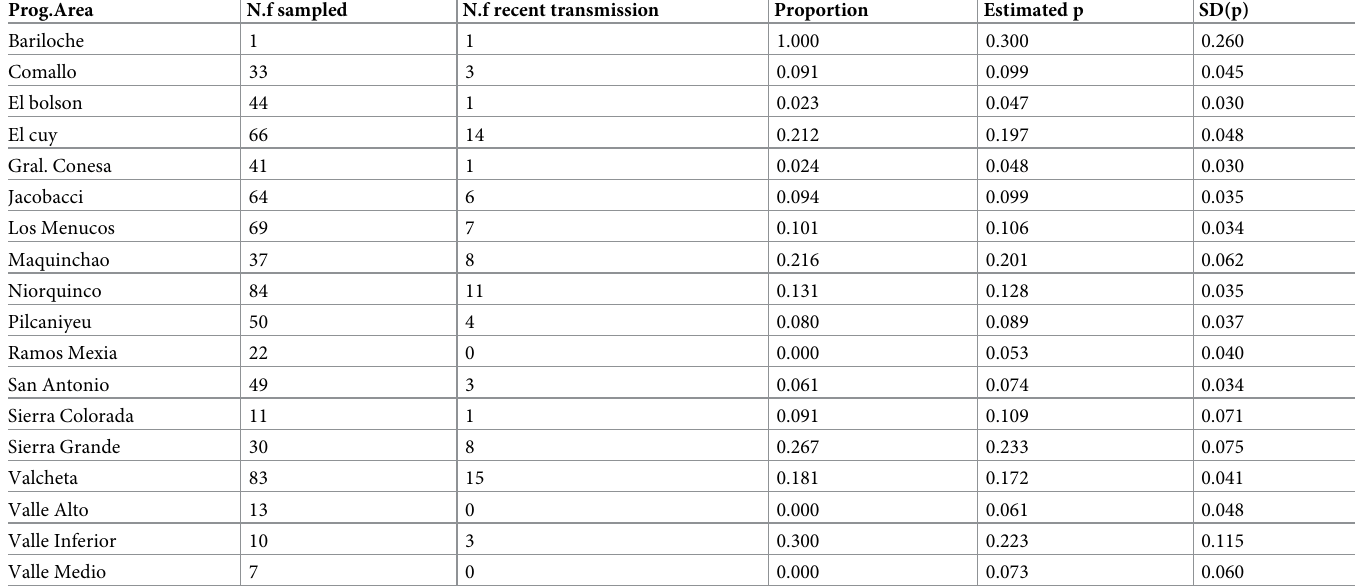
Table 1. Lamb and dog data 2003–2006. Proportion of farms with recent transmission, estimated probability of a farm having recent transmission, and standard deviation. Prog.Area N.f sampled